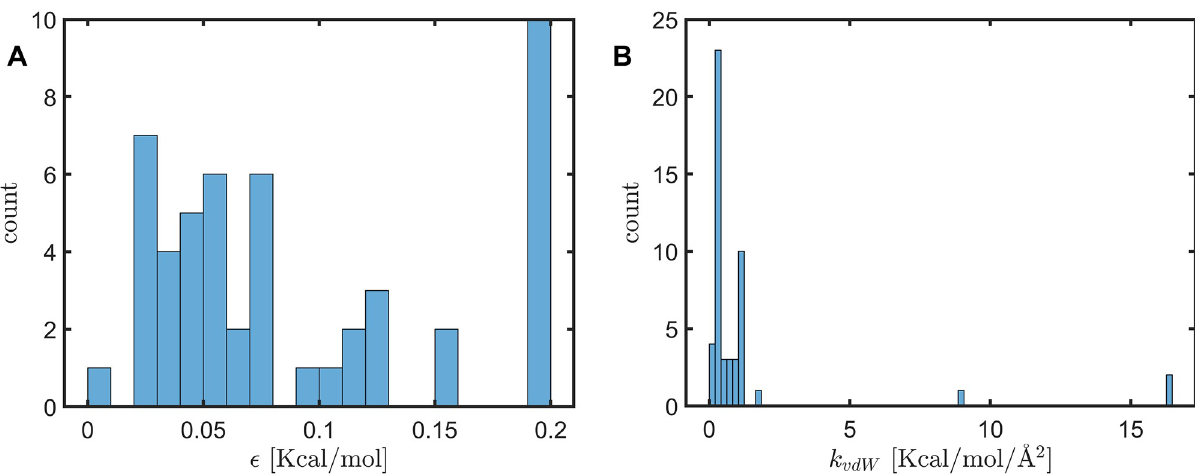
Fig 7. Histogram distributions of (A) the van der Waals parameter � used in CHARMM and (B) of k vdW ( r 0 ), the spring constant of van der Waal interactions.